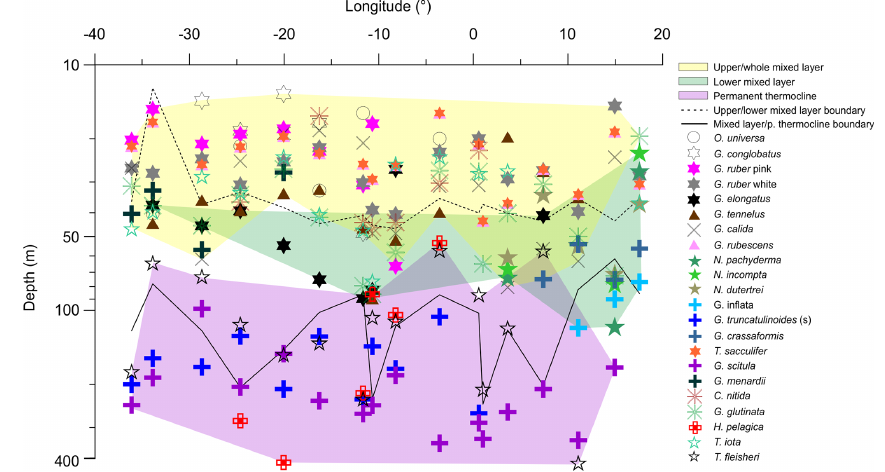
Figure 6. Average living depth (ALD) of the most abundant species along the transect in the South Atlantic. Depth groups are highlighted by different color filling. Note the ALD separation above and beneath 100m and the lower mixed layer group that is more obvious on the eastern